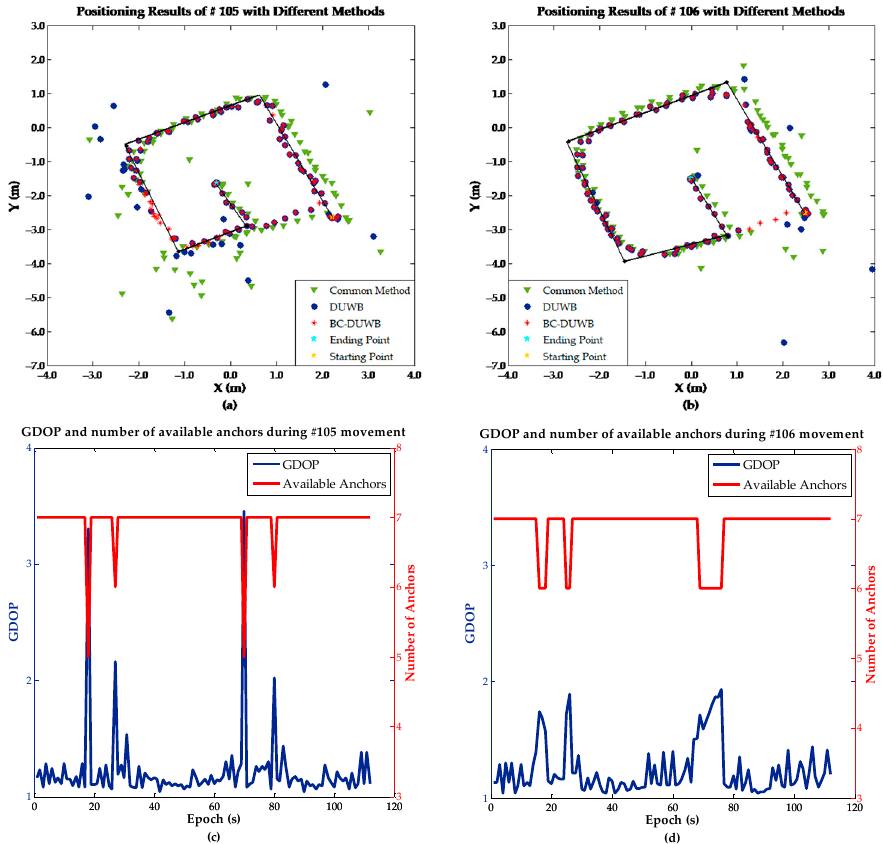
Figure 14. ( a ) The positioning results of rover #105 with different methods (Test 3); ( b ) The positioning results of rover #106 with different methods (Test 3); ( c ) GDOP and the number of available anchors during #105 movement; ( d ) GDOP and the number of available anchors during #106 movement.